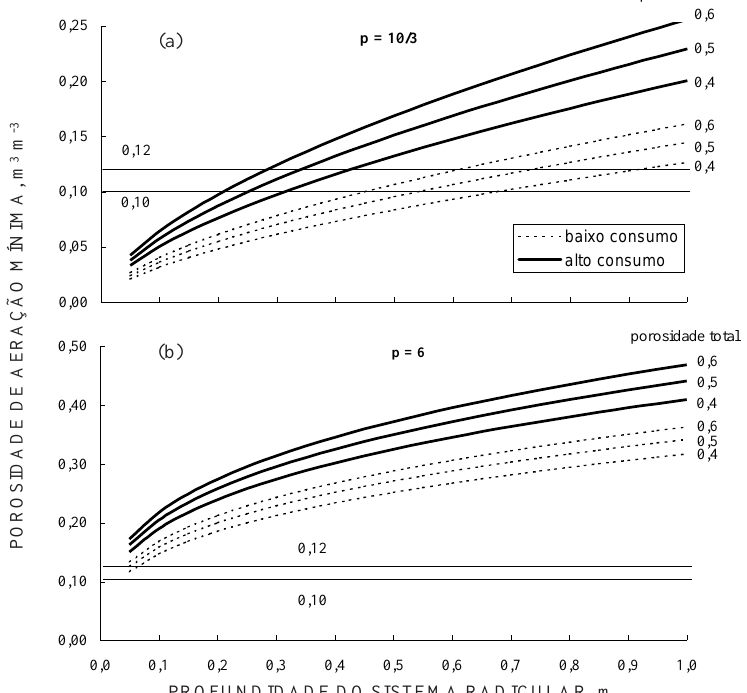
PROFUNDIDADE DO SISTEMA RADICULAR, Figura 1. Porosidade de aeração mínima necessária para que não ocorra déficit de oxigênio em nenhuma parte do sistema radicular calculada pela equação 13, em função da profundidade do sistema radicular, para diferentes porosidades totais e para baixo (6,1.10 -8 kg m -3 s -1 ) e alto (28,3.10 -8 kg m -3 s -1 ) nível de consumo de oxigênio com p = 10/3 (a) e p = 6 (b).